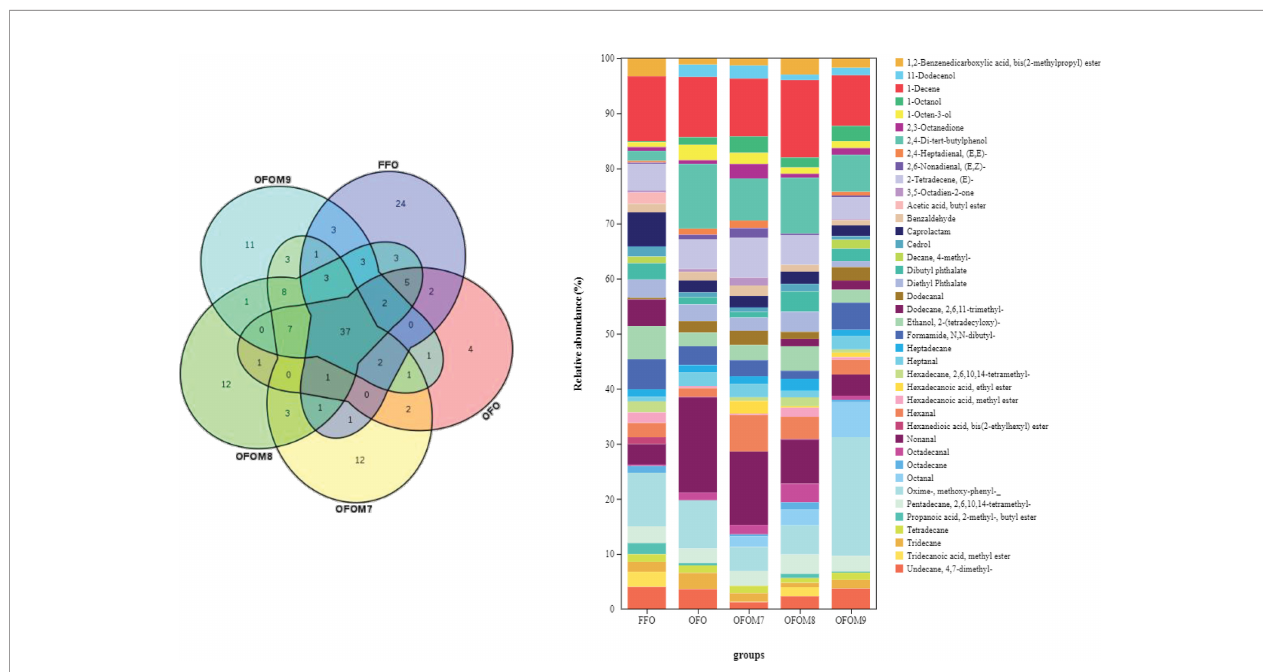
FIGURE 1 | Muscle volatile compounds species of grouper fed different